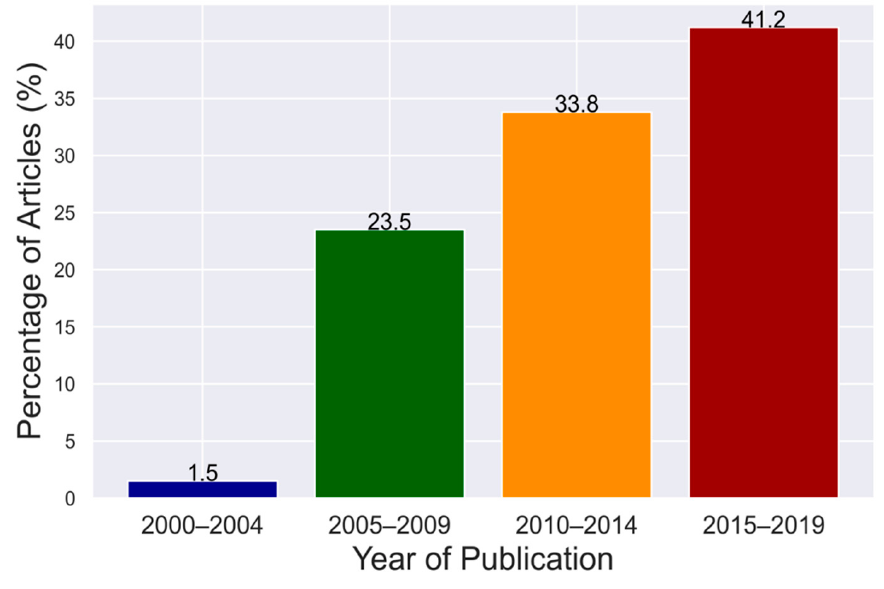
Figure 2. Number of selected articles per quarter from 2000 to 2019.